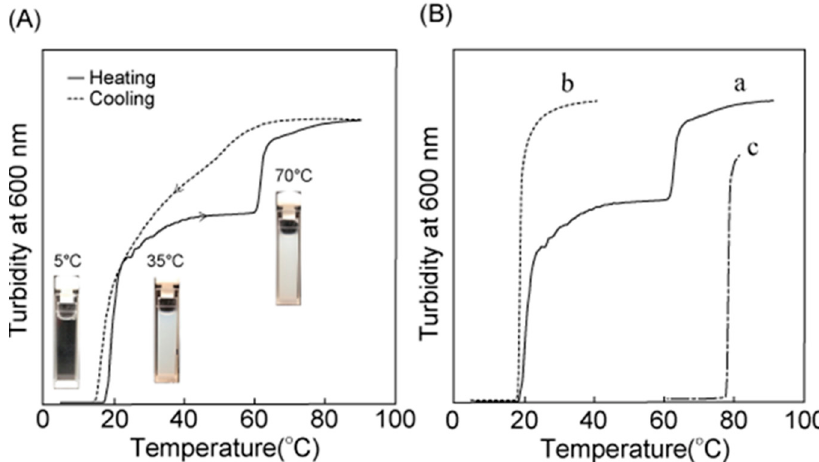
Figure 1. ( A ) Temperature dependence of the turbidity at 600 nm for poly(NAAMe 53 - b -NAGMe 240 - b - NAAMe 53 ) aqueous solution (0.25 wt %). Heating and cooling rates are constant at 1 °C min − 1 . The insets show photographs of the solution that were acquired at the indicated temperatures in the heating process. ( B ) Comparison of the turbidity curves in the heating process between the triblock copolymer poly(NAAMe n - b -NAGMe 2 m - b -NAAMe n ) (a) and the corresponding homopolymers of poly(NAAMe) (b) and poly(NAGMe 240 ) (macro-initiator) (c).